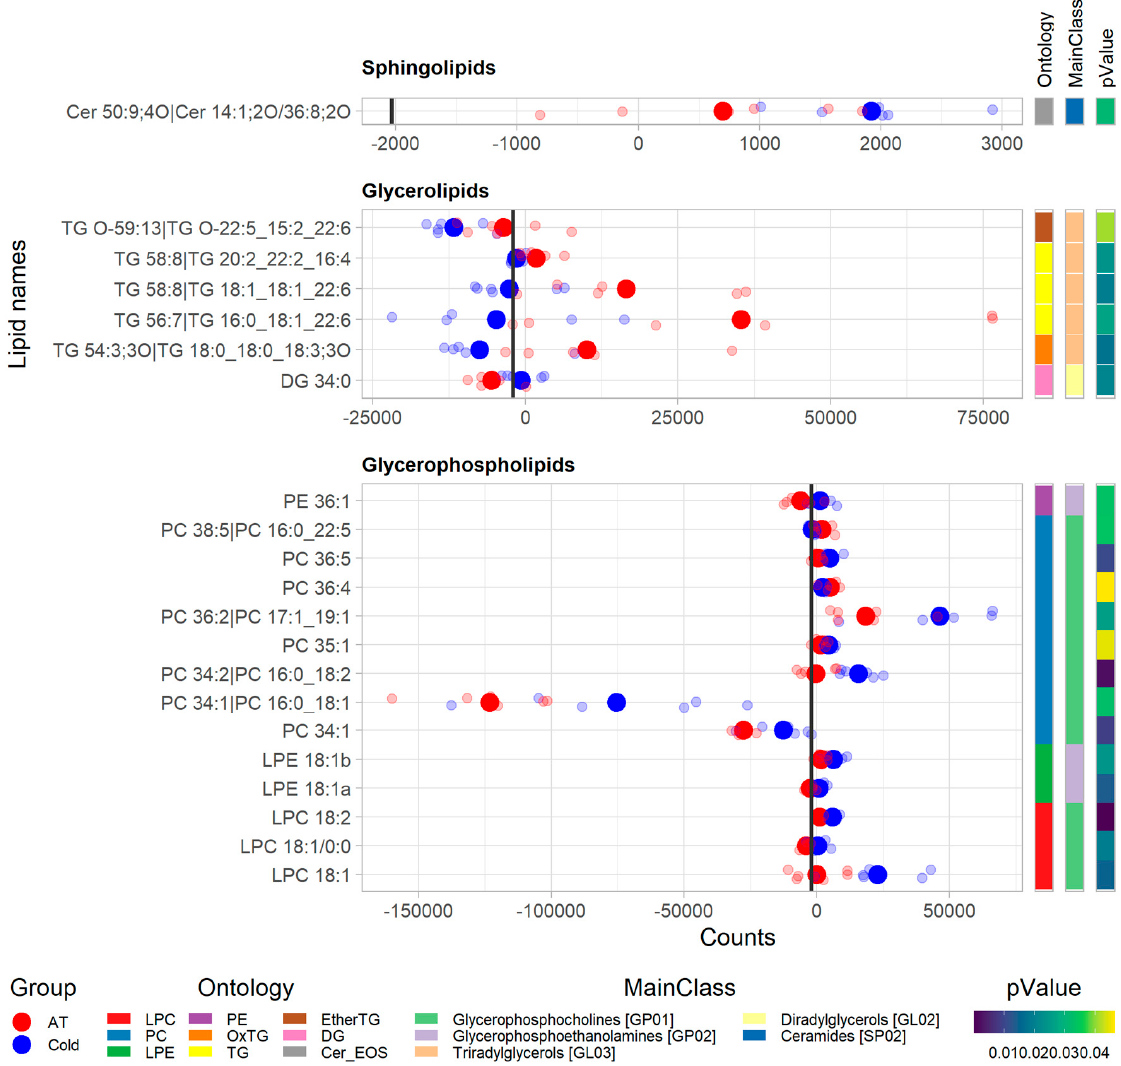
Figure 3. Plots of significantly different ( p < 0.05) lipid classes within lipid categories in brown adipose tissue (BAT) samples from new-born lambs kept at ambient temperature (20–22 ◦ C, AT in red) vs. those kept at cold temperature (4 ◦ C, cold in blue) after 2 days of exposure. Each row of dots represents a lipid metabolite with respect to its ion counts obtained from the LC-MS analysis, where big dots represent the mean and smaller dots represent the individual values ( n = 6 in each group). The vertical bold black line represents the average count value across all BAT datasets.